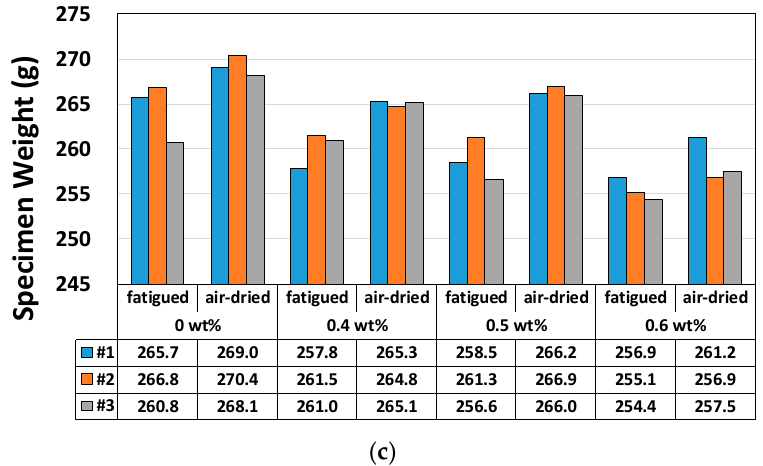
Figure 5. Freeze-thaw resistance of pitch-based carbon fiber-mortar composite: ( a ) 350 freeze-thaw cycles were applied at 50 mm × 50 mm × 50 mm (nine specimens with pitch-based carbon fiber content of 0–0.6 wt %), ( b ) relative strength relative to reference specimen strength (%) and ( c ) specimen weight (g): fatigued vs. air-dried specimen.